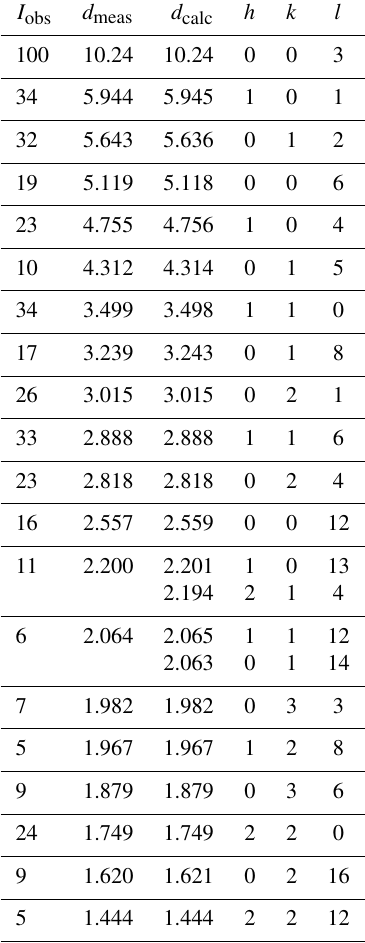
Table 2. Powder X-ray diffraction data ( d in Å) for